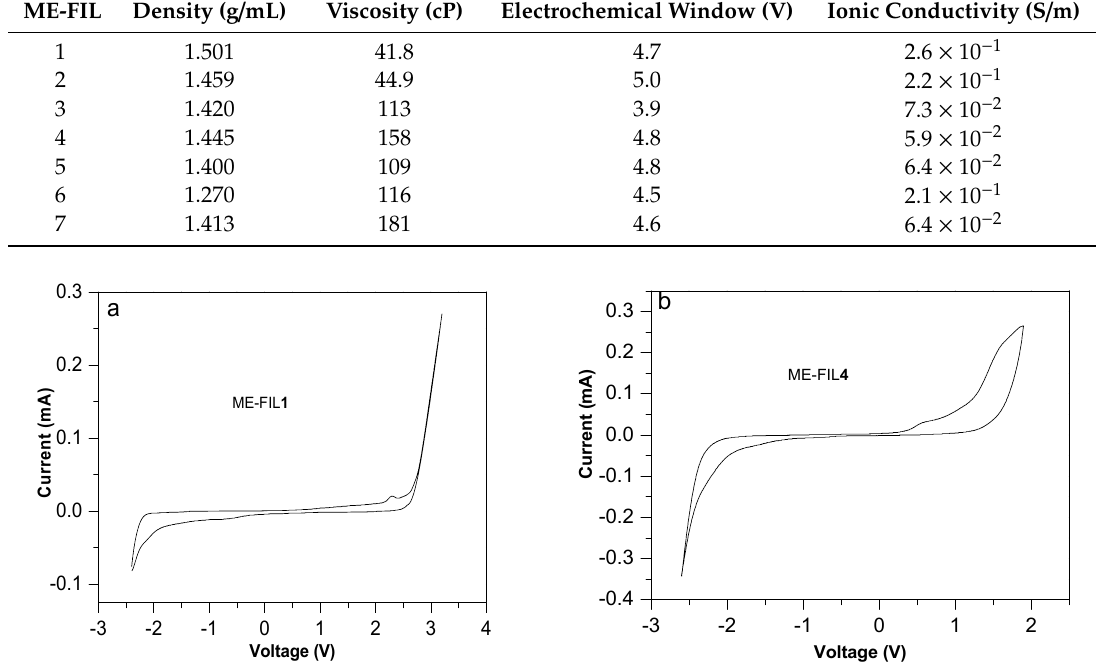
Figure 2. Typical cycle voltammograms of ME-FILs. ( a ) ME-FIL 1 ; ( b ) ME-FIL 4 .